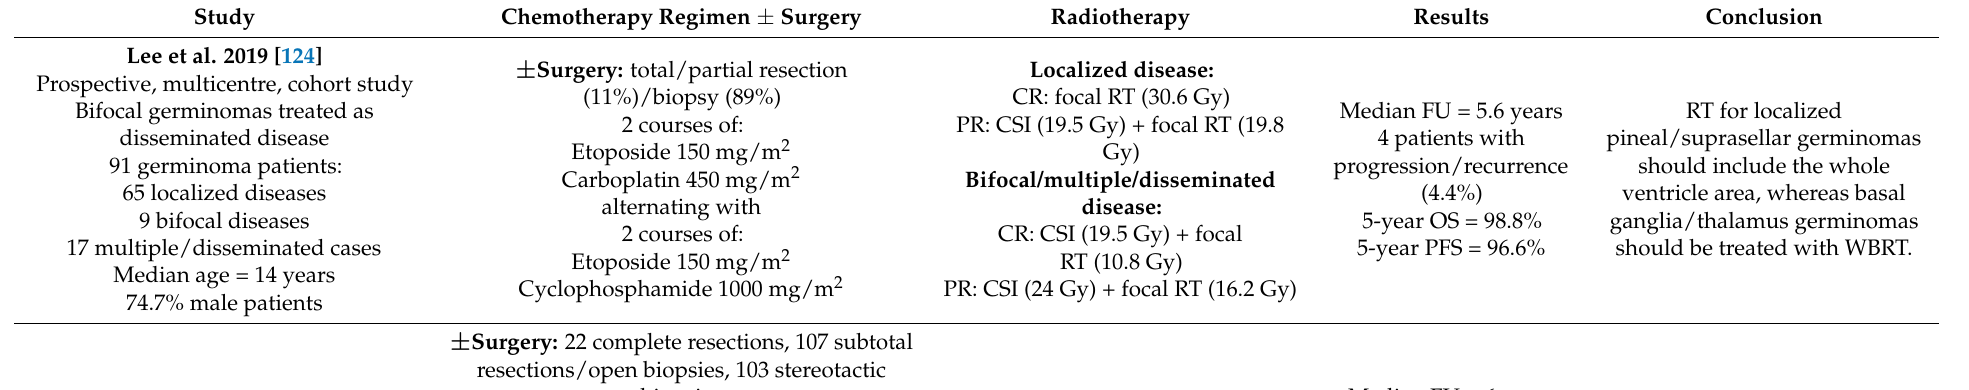
Table 8. Prospective studies regarding treatment regimes in CNS